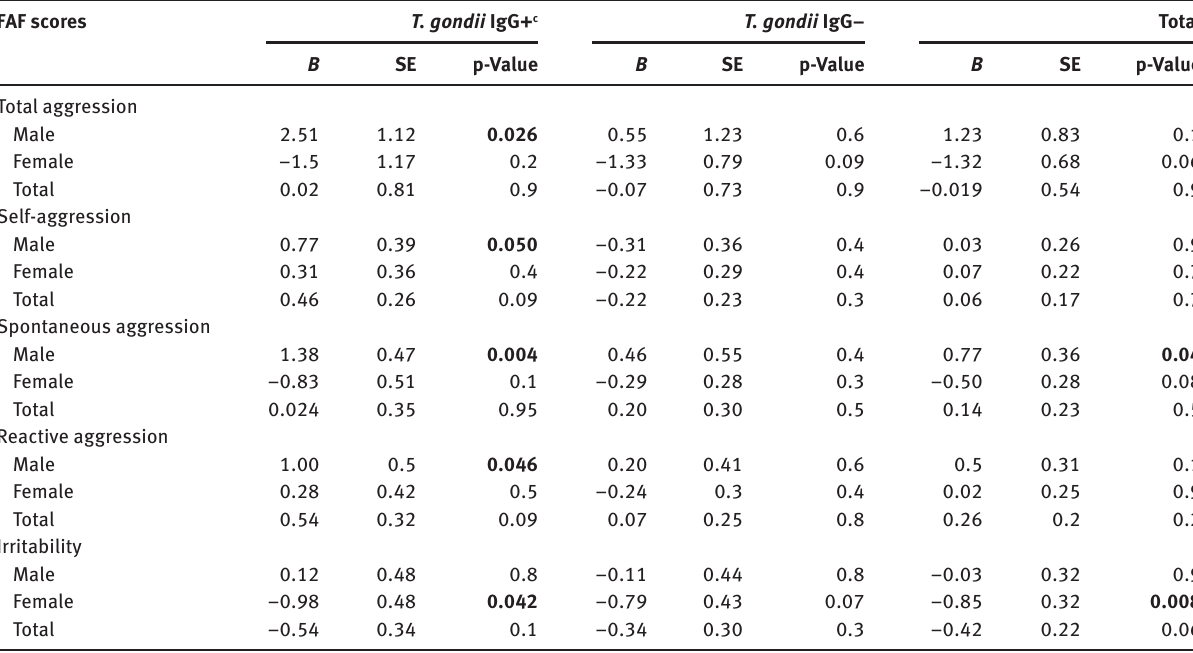
Table 2: Associations of FAF total score and selected subscale scores with Phe:Tyr rank in T. gondii positive vs. T. gondii negative individuals stratified by sex after adjustment for age, BMI and